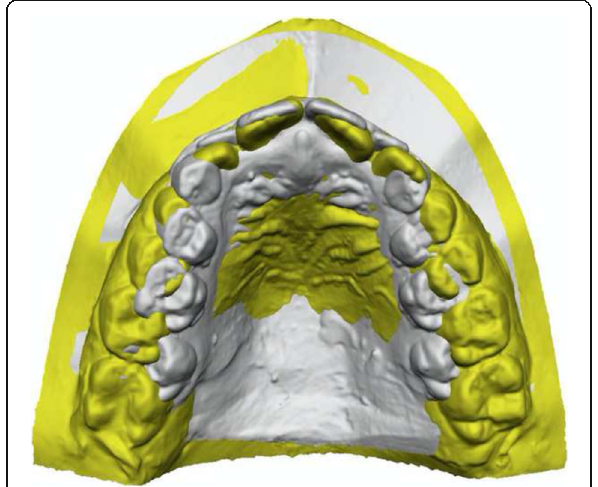
Fig. 7 Comparison between a patient with DMC (grey) and a control subject (yellow): occlusal